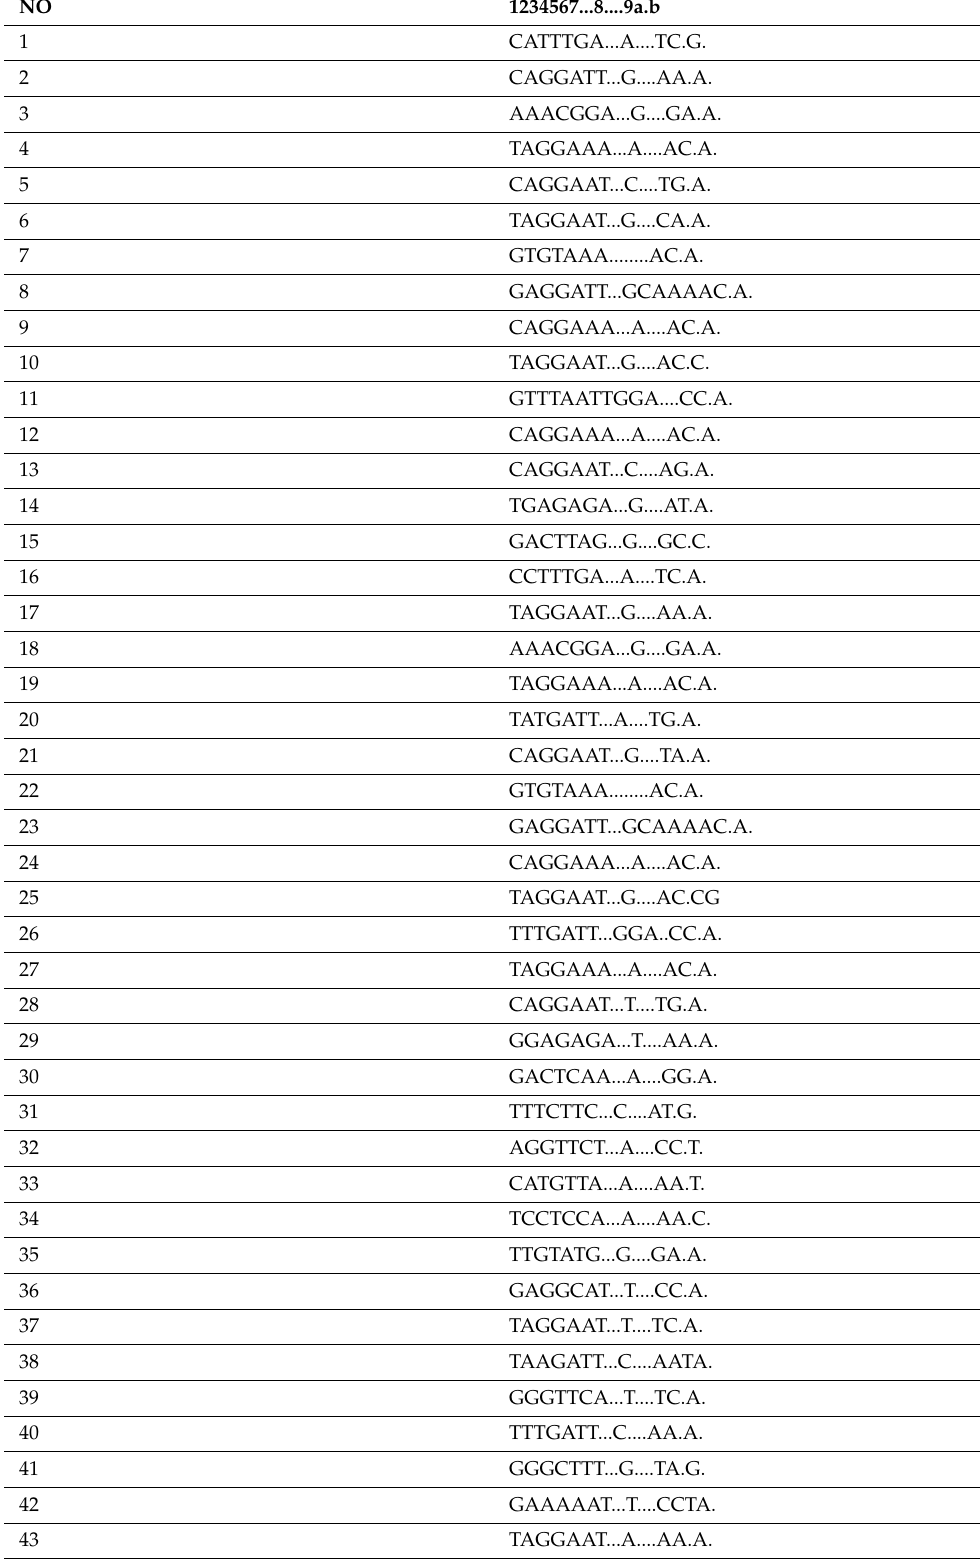
Table 2. Alignment of sequences S 2 and S for the DNA region from 2,630,061 to 2,630,589 nt of the first rice chromosome. Numbers 10 and 11 in sequence S 2 are replaced with a and